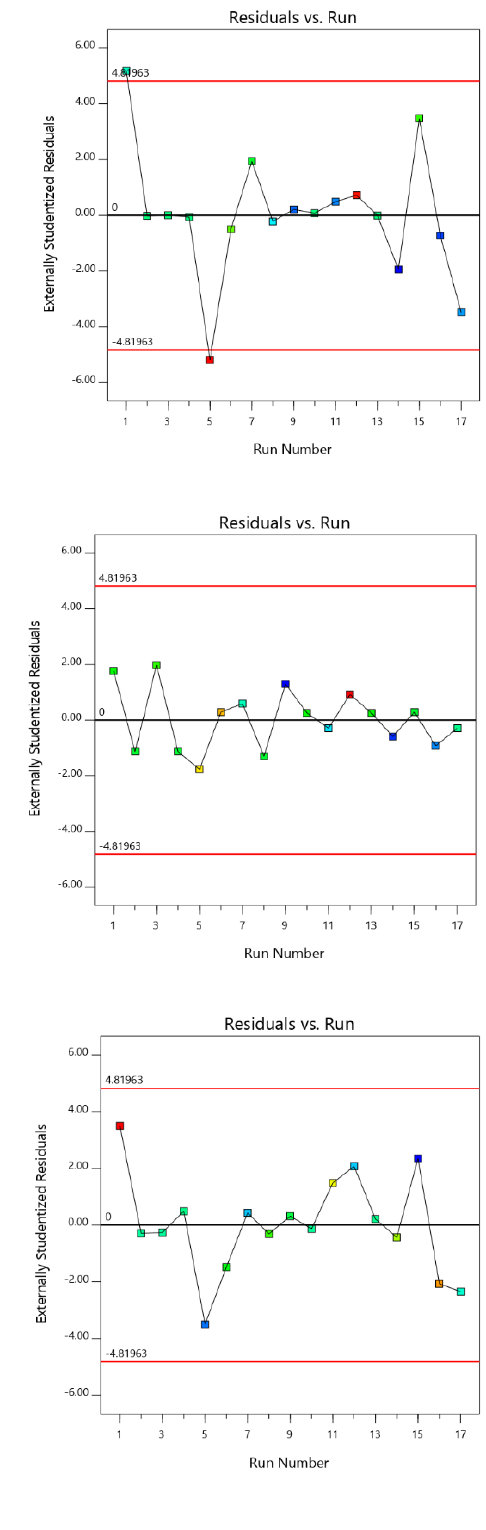
Figure 3. Normal probability and residuals plots for ( a ) PS ( b ) PDI, and ( c ) zeta potential. (Color dots represents Run number).